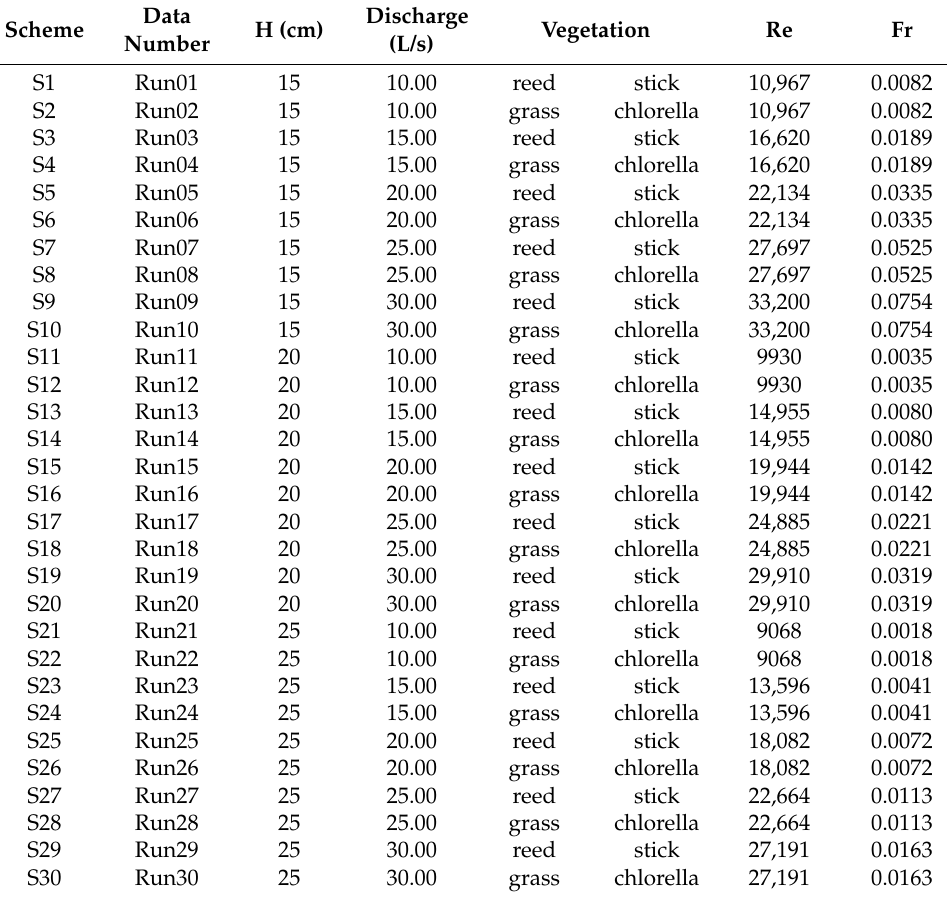
Table 1. Summary of experimental